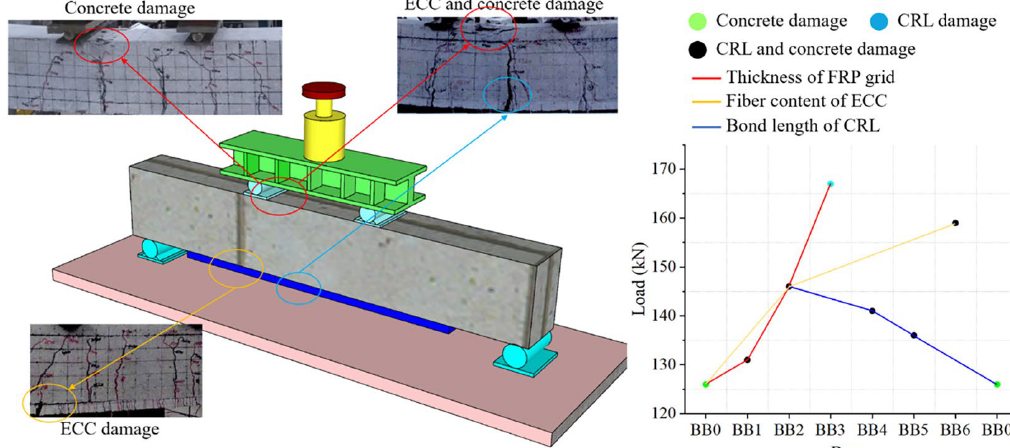
Figure 5. Ultimate loads and failure